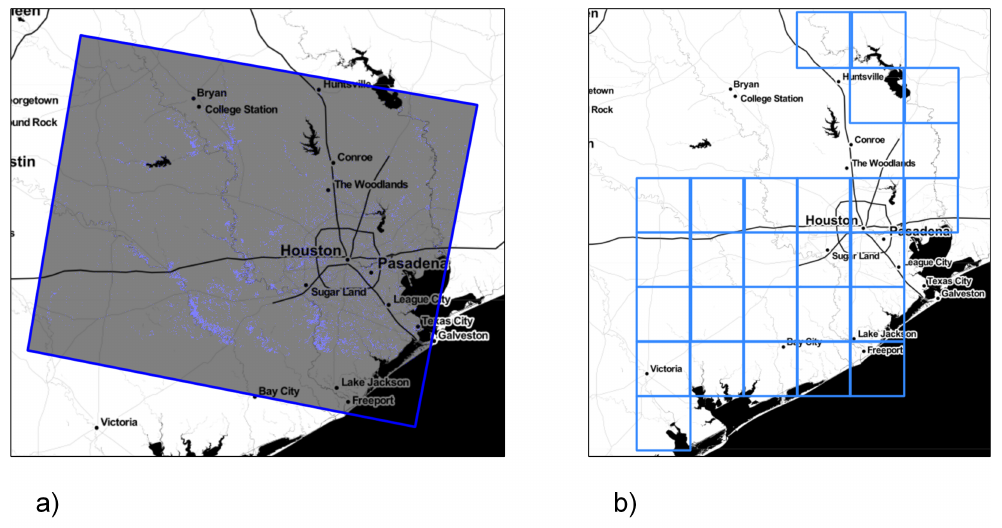
Figure 1. Flood map derived from Sentinel-1 SAR images ( a ). Spatial bounds for the query used to build our Twitter corpus related to Harvey ( b ). The map tiles are by Stamen